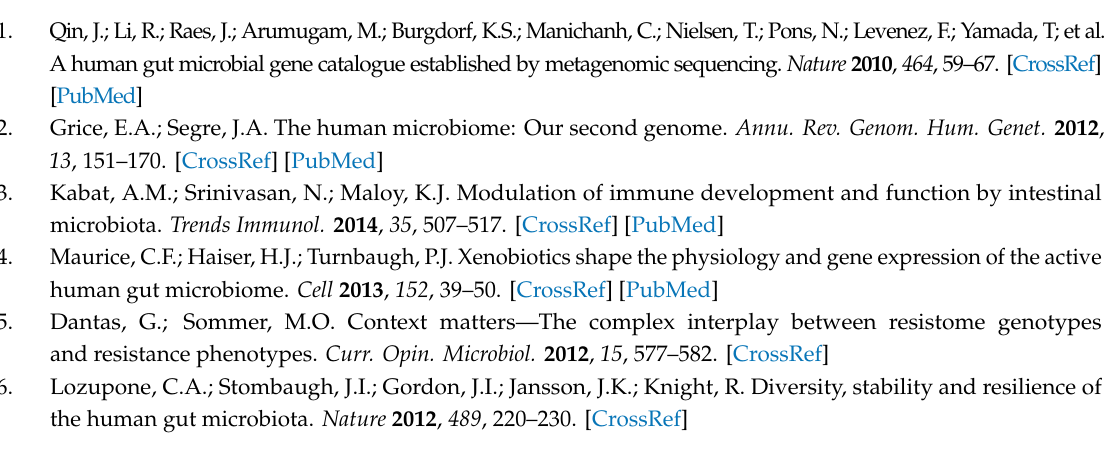
Table S1: Primers used in this study for screening of antimicrobial resistance genetic markers (ARG), Table S2: Sequence of oligonucleotide probes used for fluorescence in situ hybridization, Table S3: Anthropometric and nutritional characteristics of the participants, Table S4: Declaration of habitual intake of xenobiotic, other than antimicrobial drugs, as reported by the